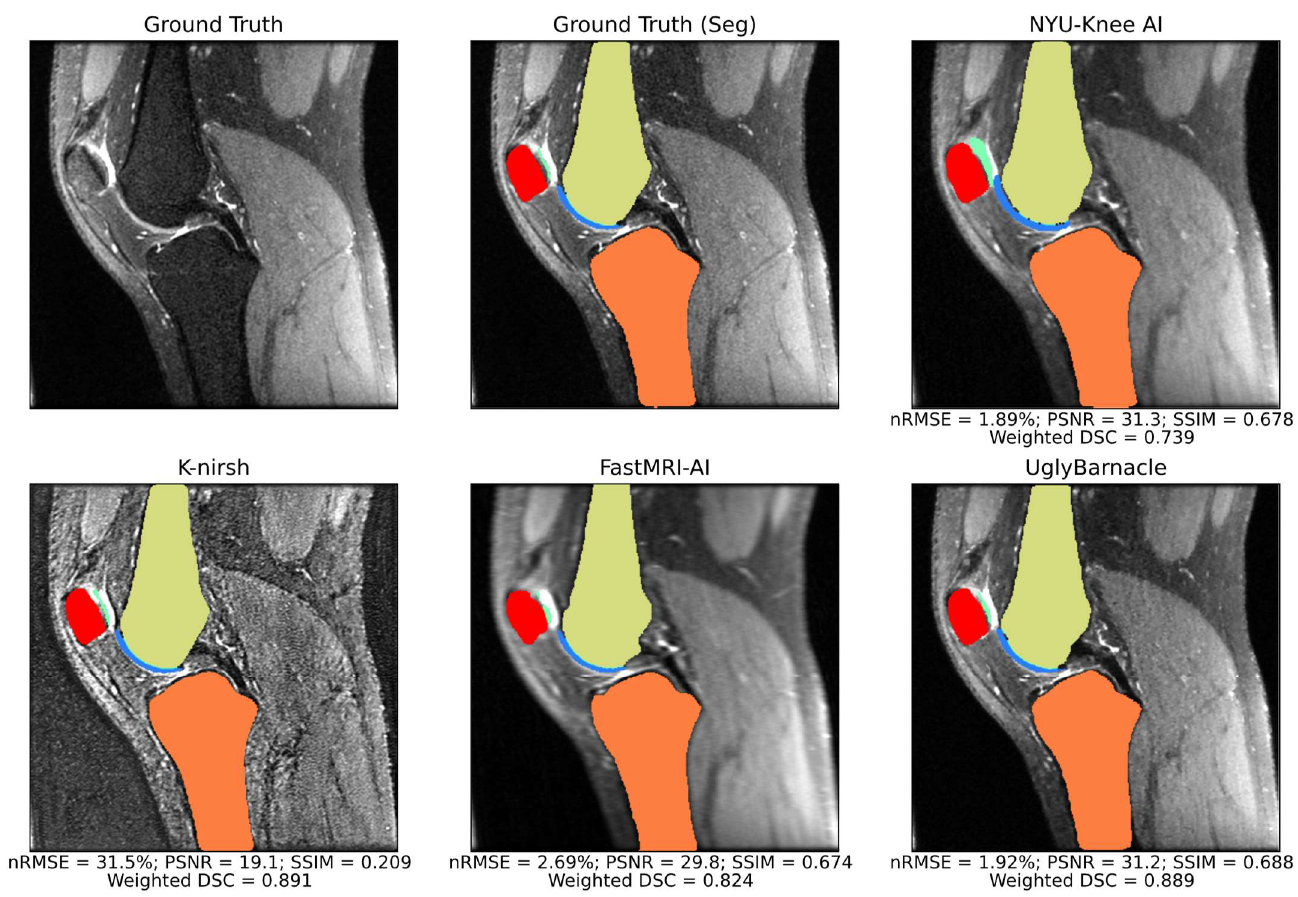
Figure 7. Sagittal slice segmentations overlaid on intermediate pipeline reconstructions, with reconstruction and segmentation metrics for the volume including the slice displayed. Background anatomy slices were thus blurrier for some teams than for others, as different teams had different quality intermediate pipeline reconstruction outputs. In this example, segmentation quality was strong for all top submissions, with only some overestimation of cartilage thickness from the NYU- Knee AI pipeline being apparent. K-nirsh maintains a slight edge over UglyBarnacle in reconstruction metrics for this volume.